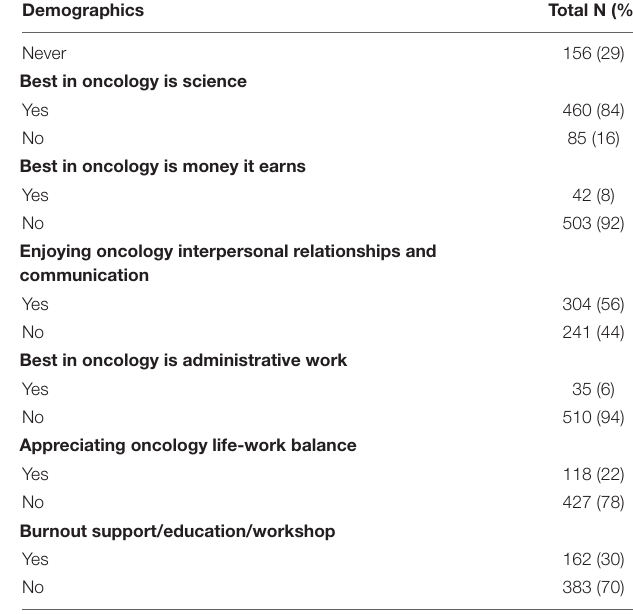
TABLE 1 | Characteristics of participating female oncology